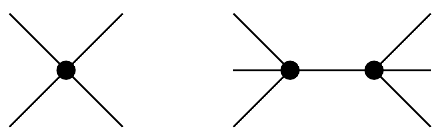
Figure 2 . An operator of four fields will contribute to the four-point amplitude as a polynomial, and the six-point amplitude as a rational